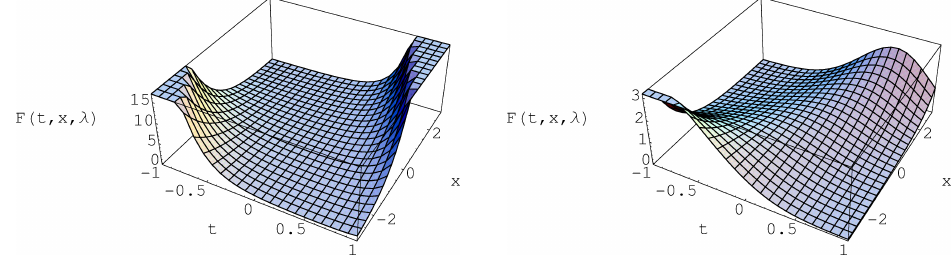
Fig. 1. The surface for the solution F.t;x;(cid:21)/